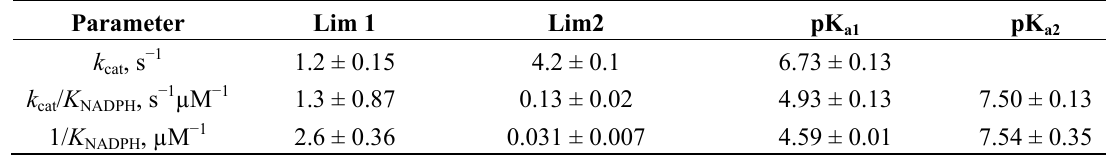
Table 3. pH dependence of the steady-state kinetic parameters of the NADPH oxidase activity of human MICAL-MO. The pH dependence of the kinetic parameters of the NADPH oxidase reaction of MICAL-MO was measured at 25 °C in the presence of a mixed buffer composed of 10 mM acetic acid, 5 mM imidazole and 5 mM Tris. pH was adjusted with NaOH and ionic strength was kept constant at 10 mM with the addition of suitable amounts of sodium acetate. The k values increase from a lower limit (Lim1) at cat acidic pH to an upper limit (Lim2) as a group with a pK of ≈ 6.7 dissociate. k / K and a cat NADPH 1/ K decreased from a (poorly defined) upper limit (Lim1) at low pH to a lower limit NADPH (Lim2) at high pH as groups with pK of 4.6–4.9 and ≈ 7.5 dissociate. a Parameter Lim 1 Lim2 pK pK a1 a2 k , s − 1 1.2 ± 0.15 4.2 ± 0.1 6.73 ± 0.13 cat k / K , s − 1 µM − 1 1.3 ± 0.87 0.13 ± 0.02 cat NADPH 1/ K , µM − NADPH